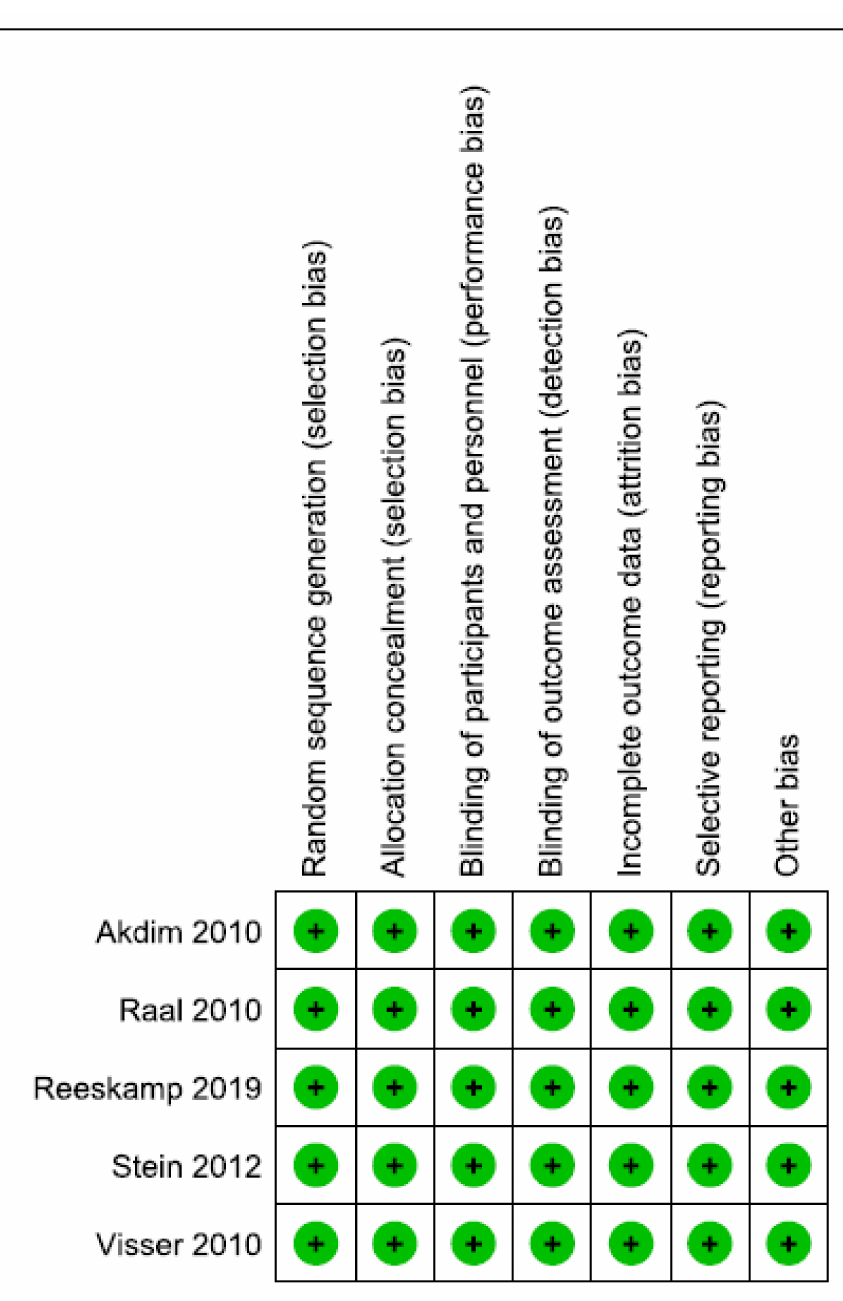
Figure 2. Assessment of risk of bias in each individual